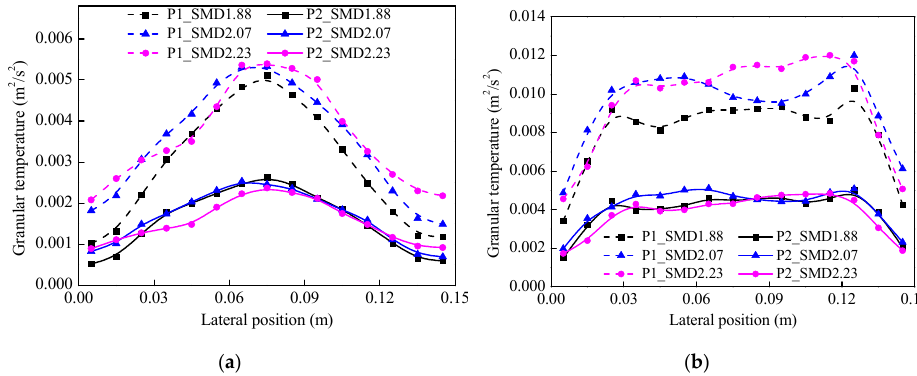
Figure 12. Time-averaged granular temperature of small and large particles with various SMD at different heights: ( a ) 0.05 m; ( b ) 0.1 m.